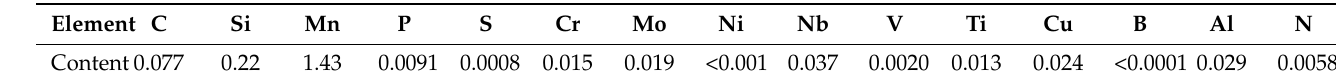
Table 5. Chemical composition of 1# pipeline (wt.%).